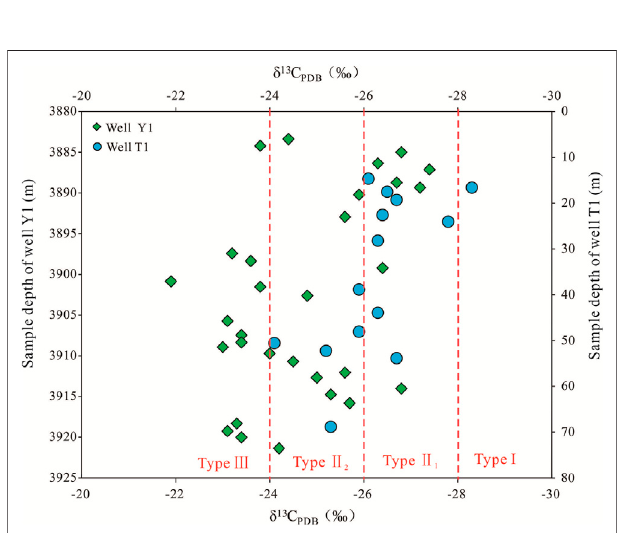
FIGURE 5 | Classi fi cation of organic matter types of the J 1 da shale samples.